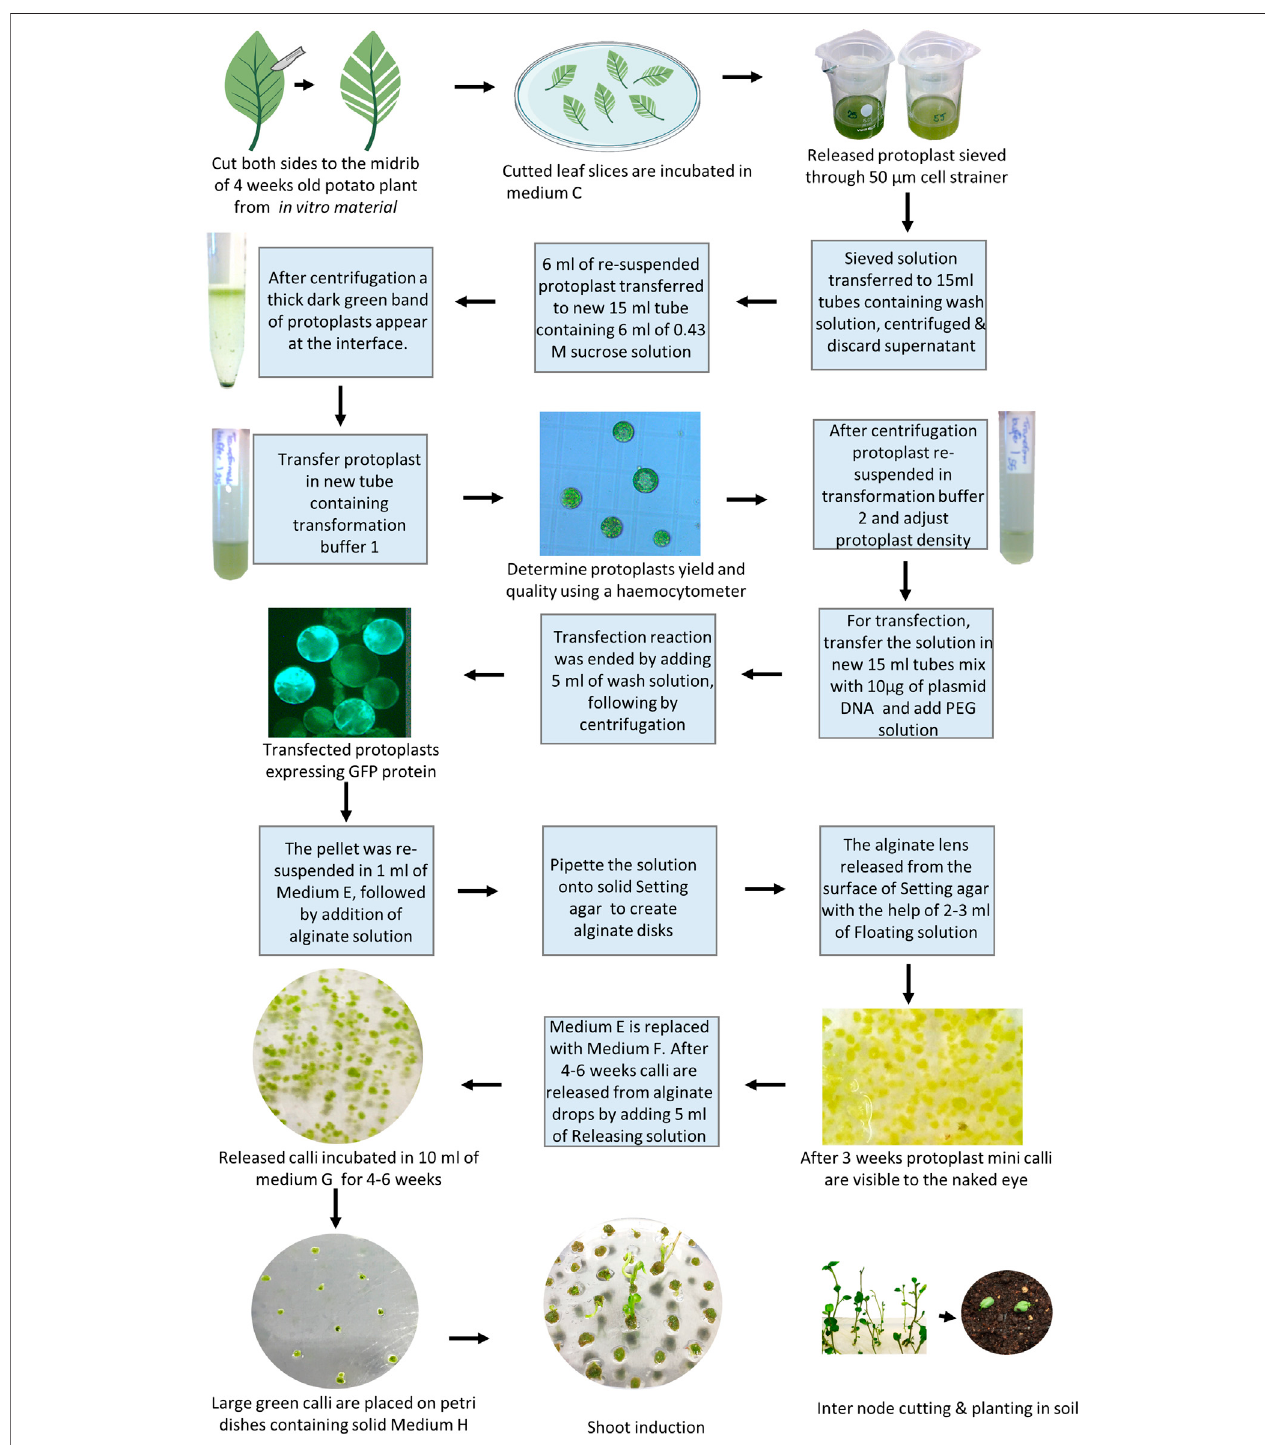
FIGURE 3 | Overview of protoplast and transfection in potato.